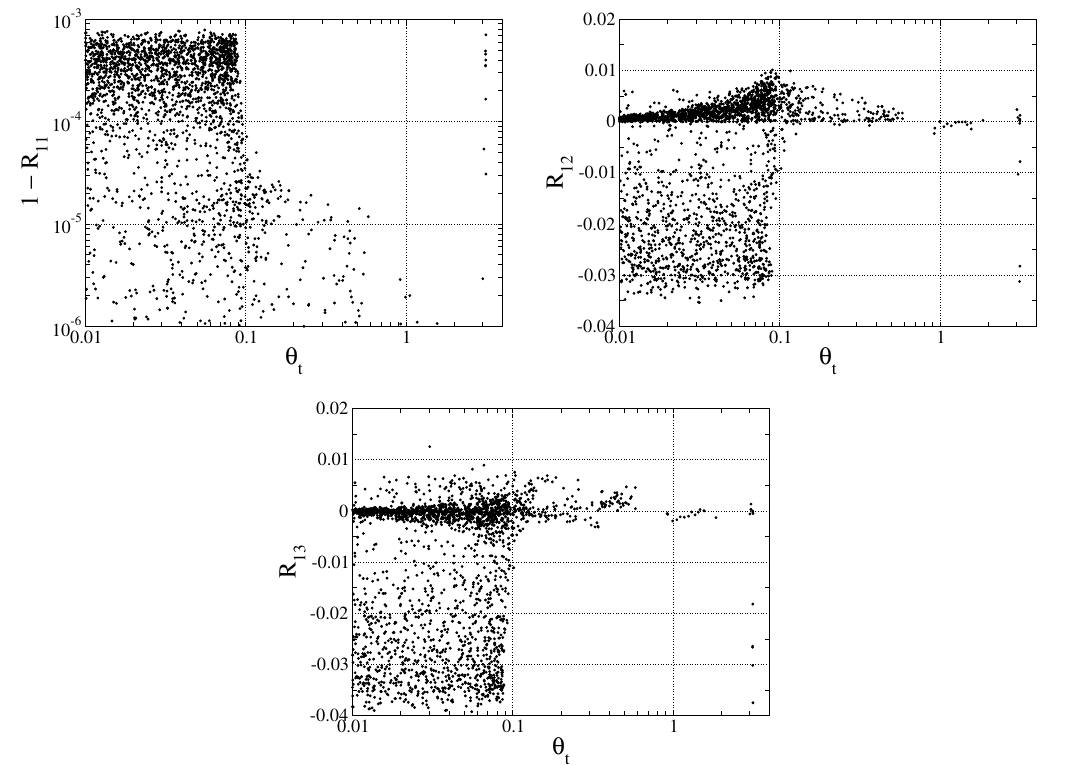
Figure 2 . θ t dependence of the values of 1 − R 11 (left), R 12 (center) and R 13 (right), where the mixing matrix R is defined in eq.